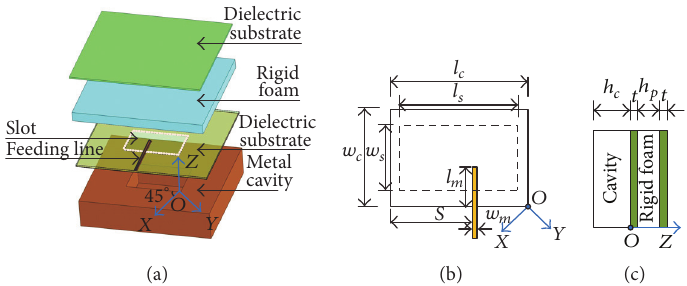
Figure 4: Configuration of the slant polarized IMF-CBSA element. (a) 3D model; (b) top view; (c) side view.